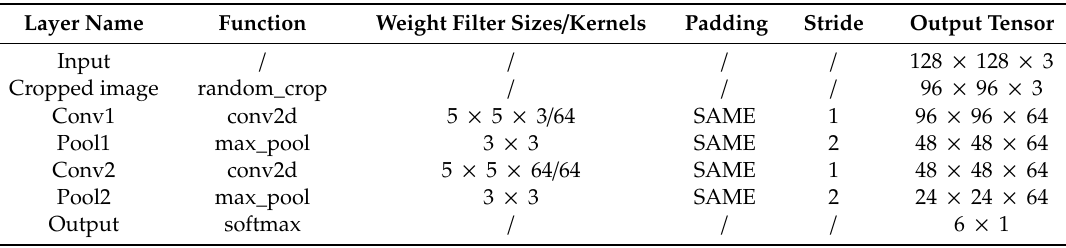
Table 1. Parameters and output shapes of the RTCNNs model.